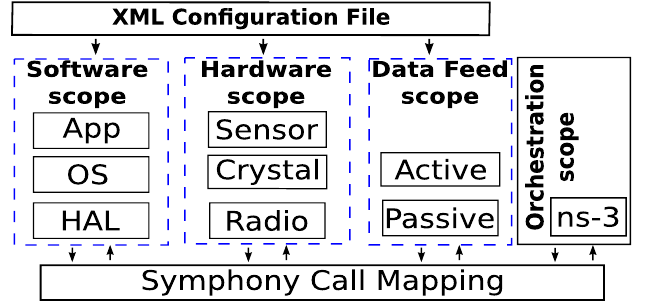
Figure 1. Architecture of the Symphony framework. Programming scopes are developed independently and later configured using XML file which describes nodes model.